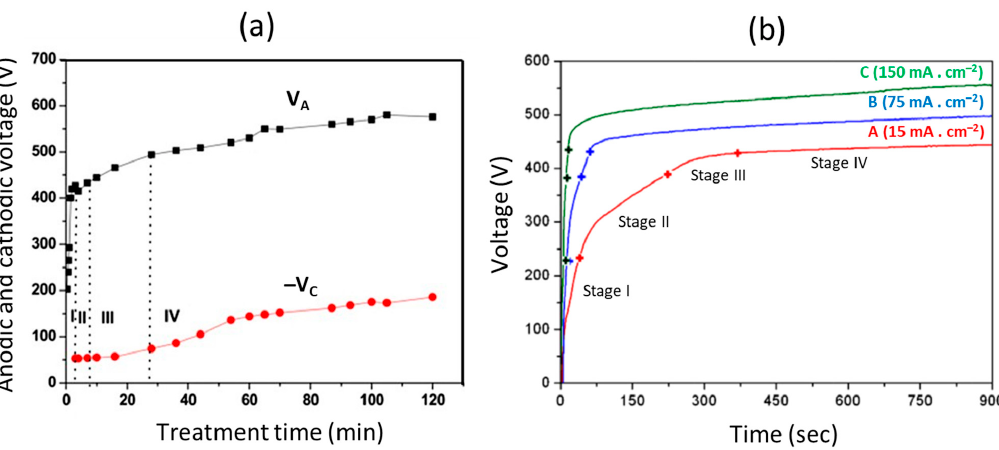
Figure 7. Graphs of voltage versus time for a PEO process pertaining to ( a ) AJ62 Mg alloy and ( b ) AM50 Mg alloy. Reproduced with permission from [12]. Copyright IntechOpen, 2014.